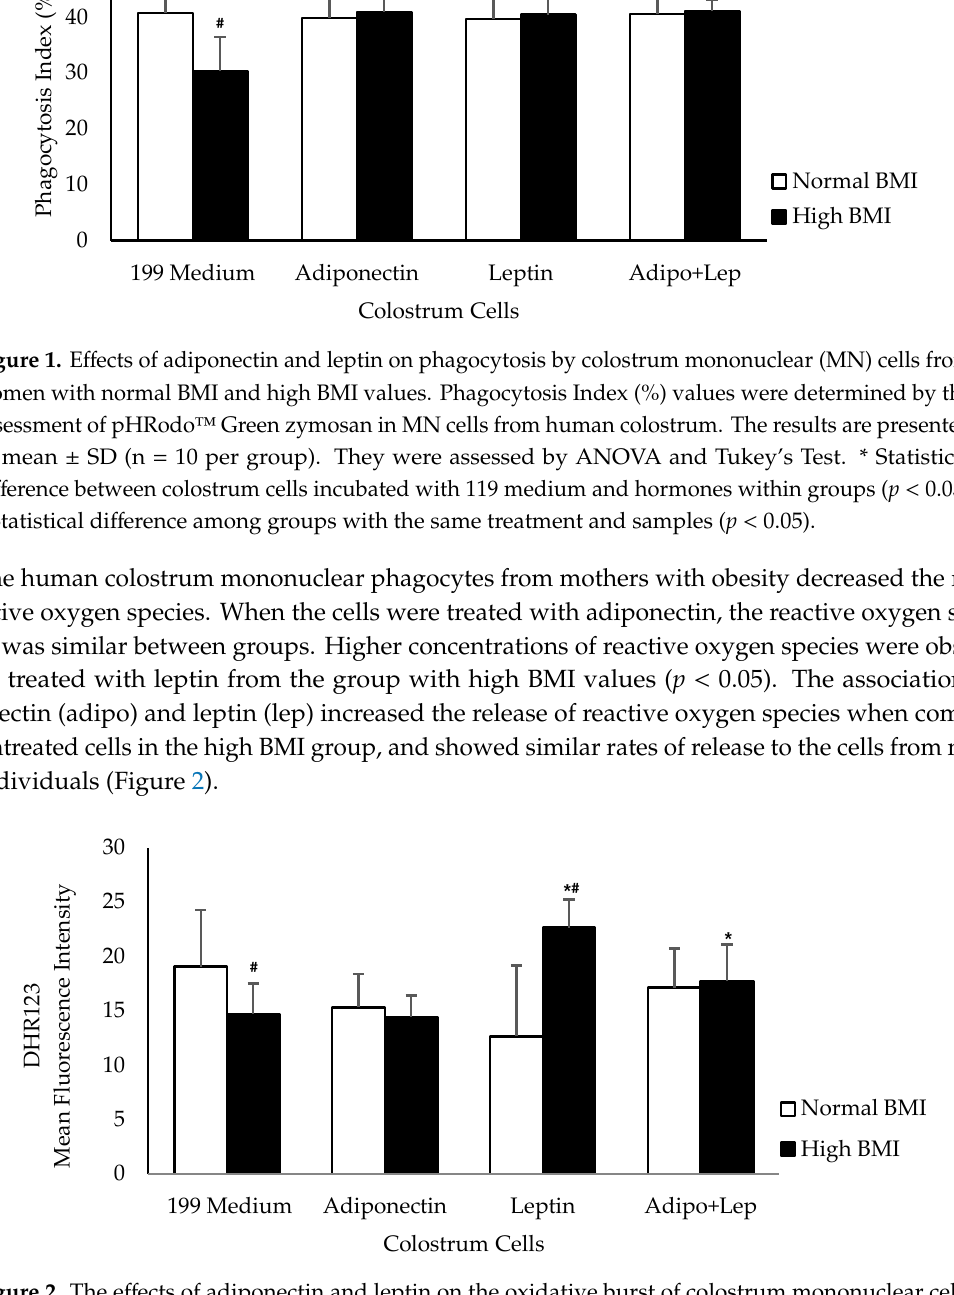
Figure 2. The effects of adiponectin and leptin on the oxidative burst of colostrum mononuclear cells from women with normal BMI and high BMI values incubated with Zymosan A from Saccharomyces cerevisiae . Reactive oxygen species were released by colostrum mononuclear phagocytes. The results are presented as mean ± SD (n = 10 per group) and assessed by ANOVA and Tukey’s Test. * Statistical difference between colostrum cells incubated with 199 medium and hormones within groups ( p < 0.05). # Statistical difference among groups with the same treatment and sample ( p < 0.05).